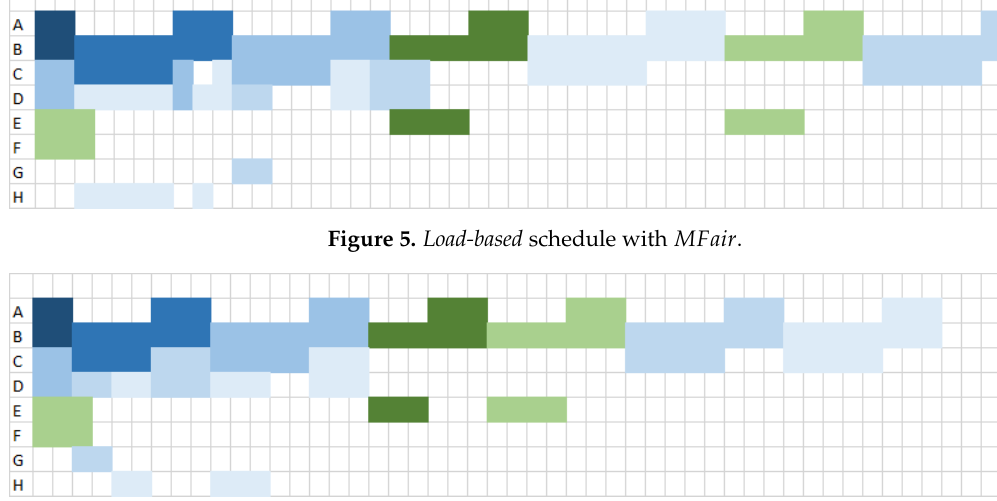
Figure 6. Load-based schedule with MOpt